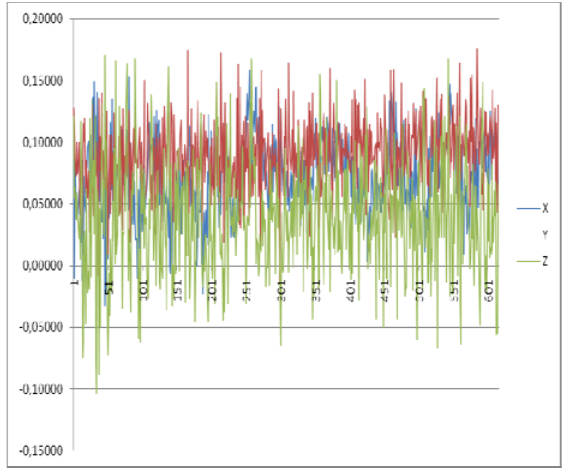
Figure 8. Graphic of Orientation parameter gaps